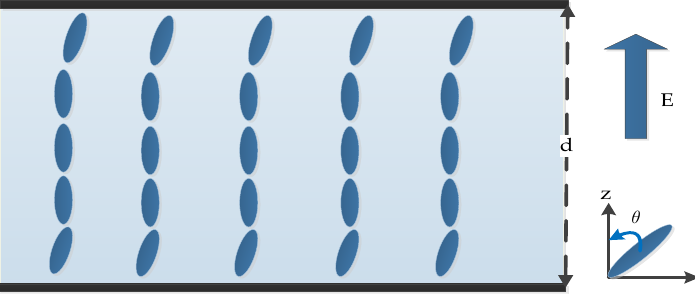
Figure 1. Schematic drawing of a Nematic Liquid Crystal cell .